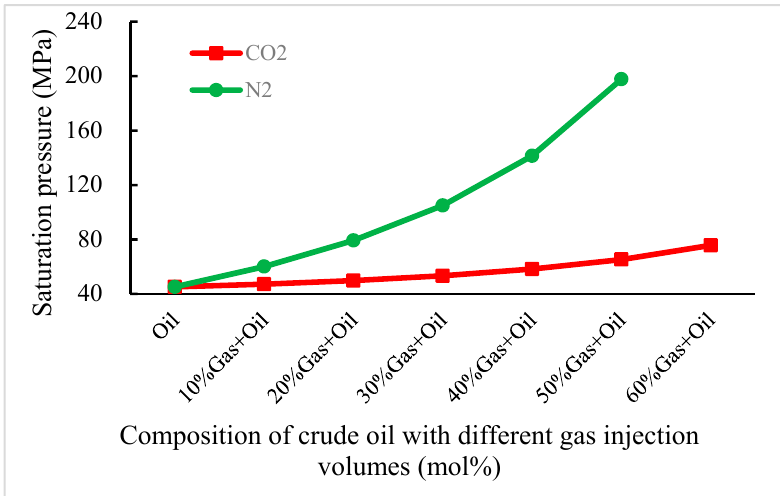
Figure 5. An asphaltene deposition pressure change with different injection volumes of CO 2 and N 2 at 161.8 °C in a buried-hill reservoir.